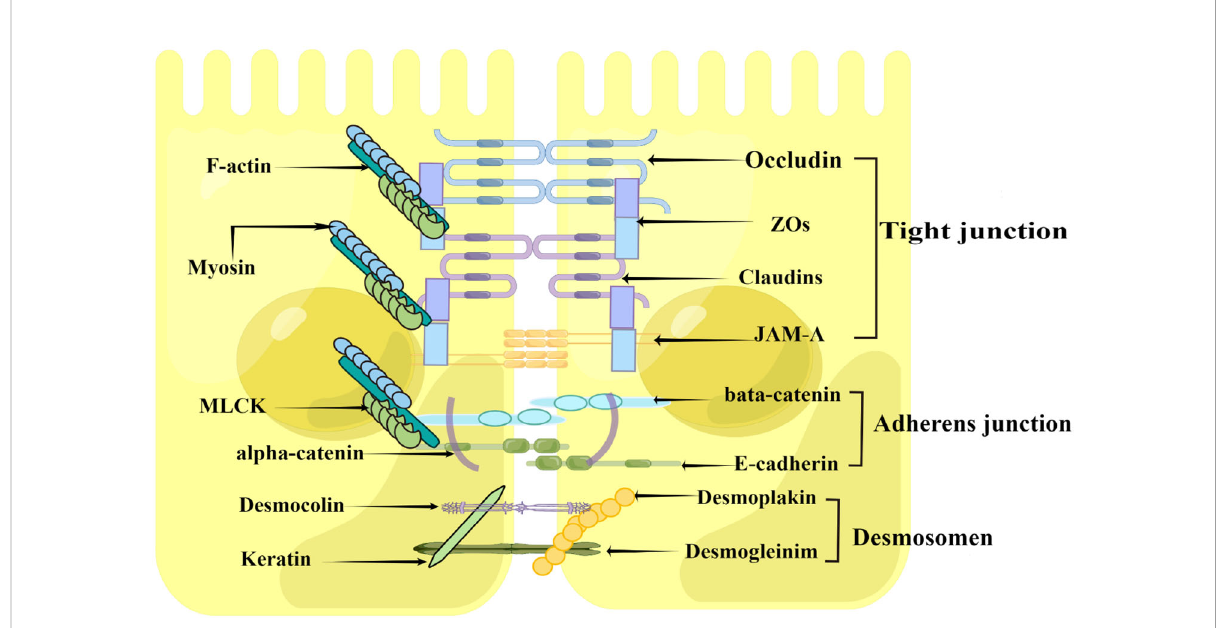
FIGURE 2 Construction of the intestinal epithelial barrier (By Figdraw). The intestinal epithelial barrier is mainly formed by a layer of epithelial cells joined together by the apical junctional complex (APC), including tight junctions, adherent junctions, and desmosomes. The tight junctions constitute the major determinant of the intestinal physical barrier, which is mainly composed of Claudin, Occludin and junctional adhesion protein molecule-A (JAM-A), zonula occludens (ZO)-1, Myosin, F-actin, and Myosin light chain kinase